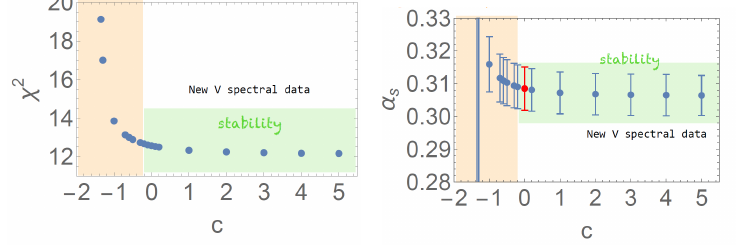
Figure 4. χ 2 (left panel) and α s ( m τ ) (right panel) as functions of c (see text) from a fit to the new V -channel tau data. The red point is our result for w 0 = 1 in the RHS panel of Fig. 2. A variation which does make sense is obtained by multiplying the expression (3) by a correction (1 + c / s ), with c a constant [11], which the authors of Ref. [26] also explored, obtaining the results α s ( m τ ) = 0 . 319 and α s ( m τ ) = 0 . 260 for the choices c = − 1 . 35